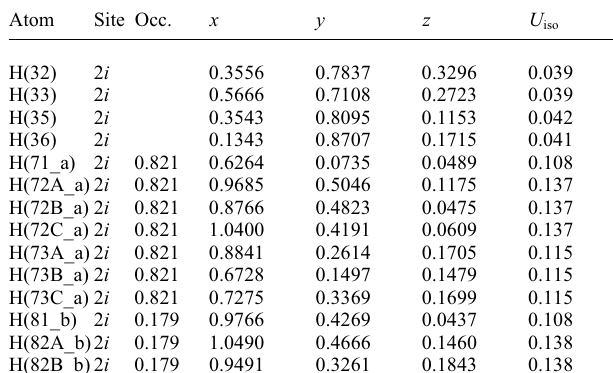
Table 2. Atomic coordinates and displacement parameters (in Å 2 )